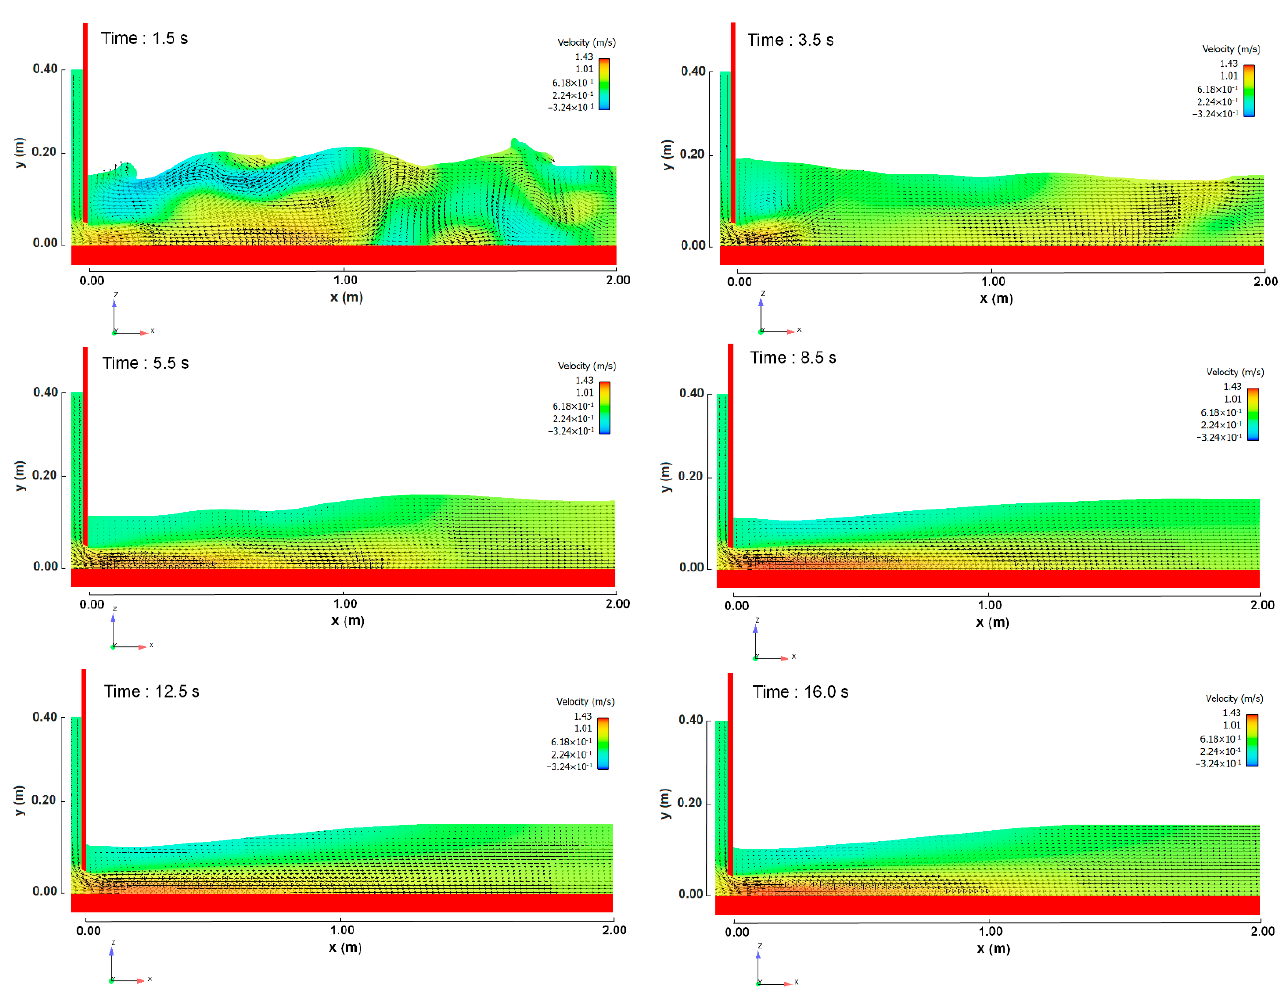
Figure 6. The evolutionary process of a submerged hydraulic jump on the smooth bed— Q = 0.03 m 3 /s. To check the accuracy of the FLOW-3D software, comparisons between numerical and experimental results were performed. Basic parameters including the submerged ratio and tailwater ratio ( y 3 /y 1 and y 4 /y 1 ) of a submerged hydraulic jump on a smooth bed and with triangular macroroughnesses with T/I = 0.25 and 0.5 were extracted from the numerical simulations and plotted as shown in Figure 7. From the graphs, a strong agreement can be observed between numerical and experimental results by Ahmed et al. [20] as a function of Fr 1 . The overall maximum error and mean value of relative error are 8.41 and 4.83%, respectively, which confirms the capability of the numerical model to predict the main properties of a submerged hydraulic jump in terms of water depths.